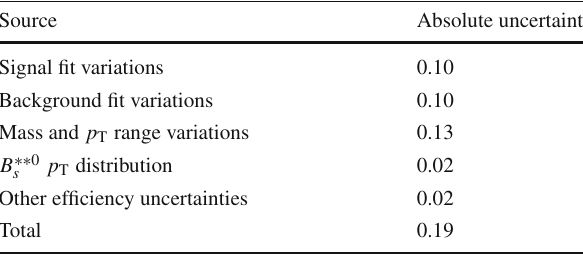
Table 2 Summary of the systematic uncertainties on the production ratio. The effect of the unknown p T distribution is separated from